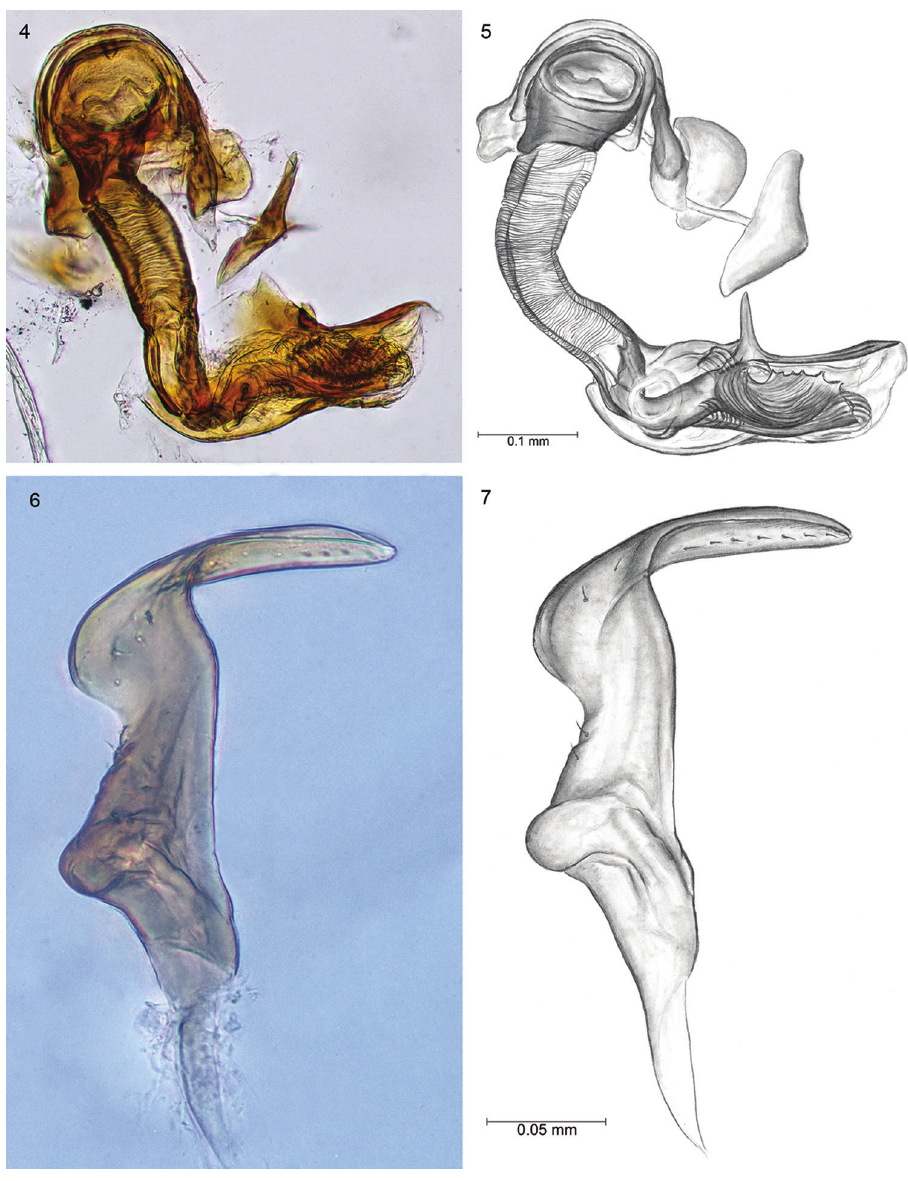
Figures 4–7. 4, 5 Photograph and drawing of aedeagus and endosoma 6, 7 Photograph and drawing of left paramere. Scale bars 0.1 mm 4, 5 ; 0.05 mm 6, 7